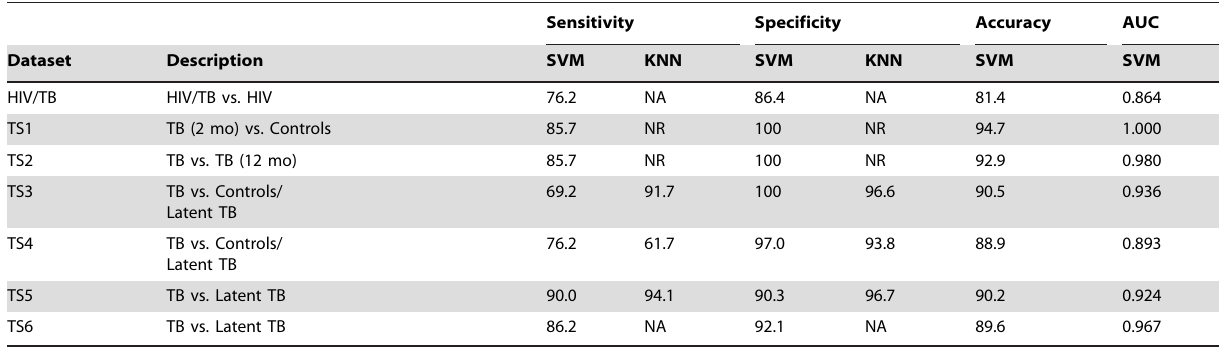
Table 4. Performance of